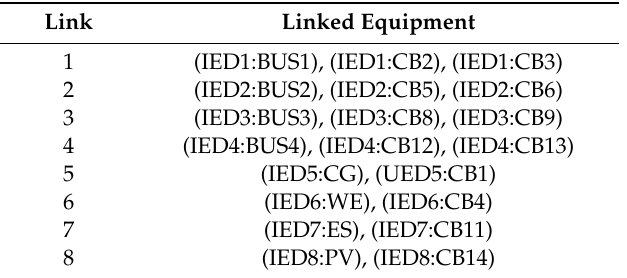
Table 5. Cyber-power links between power and cyber network. Link